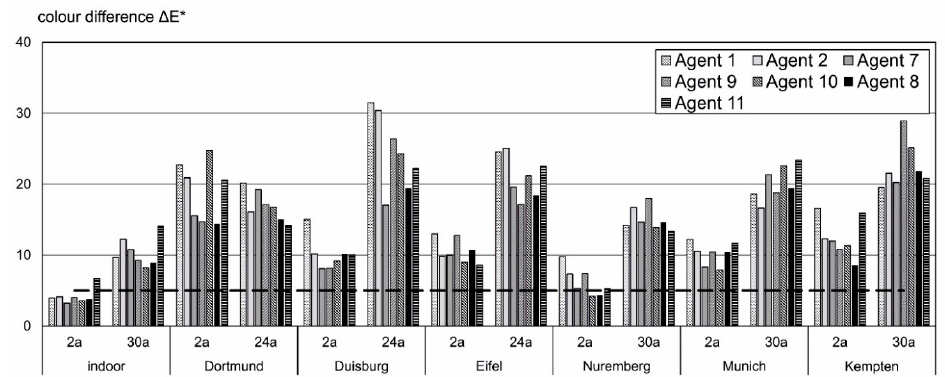
Figure 5. Total colour difference Δ E* of Obernkirchener Sandstone (OKS) samples, treated with silanes (agent 1, 2), siloxanes (agent 7, 9, 10) and silicone resins (agent 8, 11) from different exposition sites.